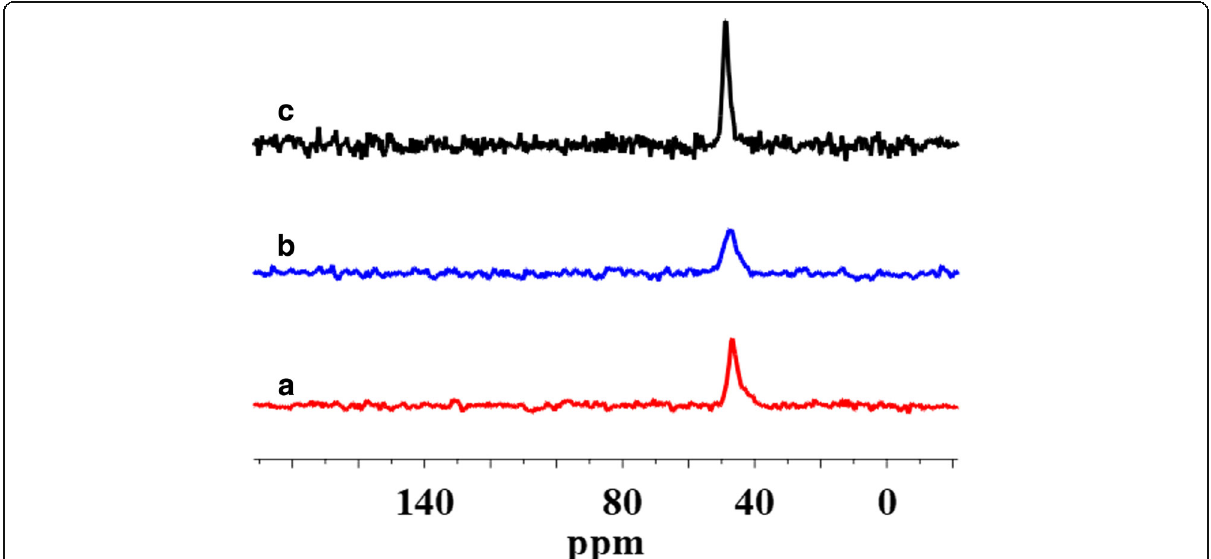
Fig. 5 13 C CP/MAS NMR spectra of ( a ) modified fumed silica with neat PMHS, modified with ( b ) mixtures of PMHS and dimethyl carbonate and ( c ) mixtures of PMHS and diethyl